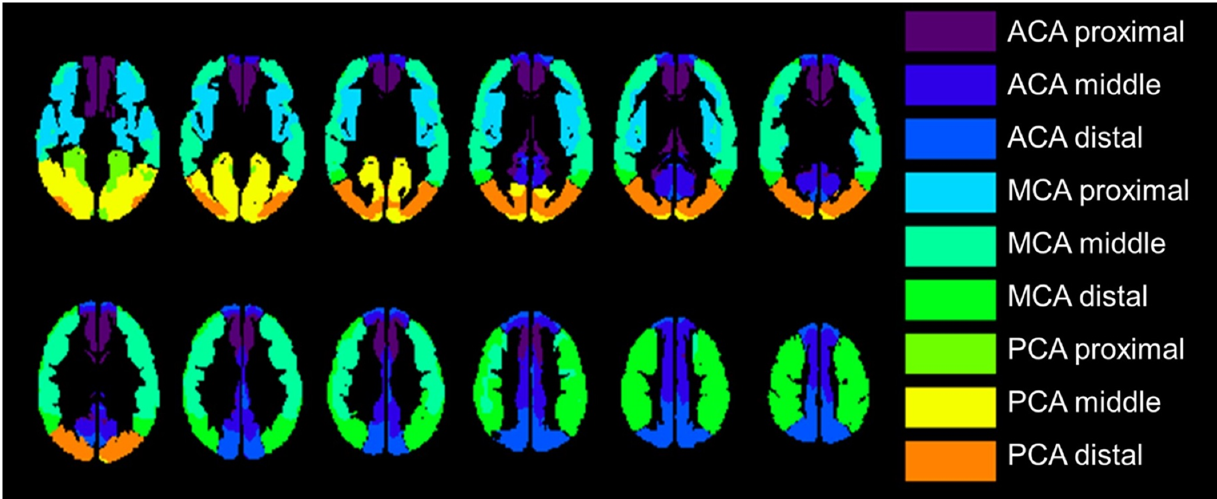
Figure 2. The regions of interest (ROI) were placed proximal, middle, and distal to the major vascu ‐ lar territories with structures located in the deep gray matter not included (e.g., basal ganglia and thalamus); 18 regions were measured per case. ACA, anterior cerebral artery; MCA, middle cerebral artery; PCA, posterior cerebral